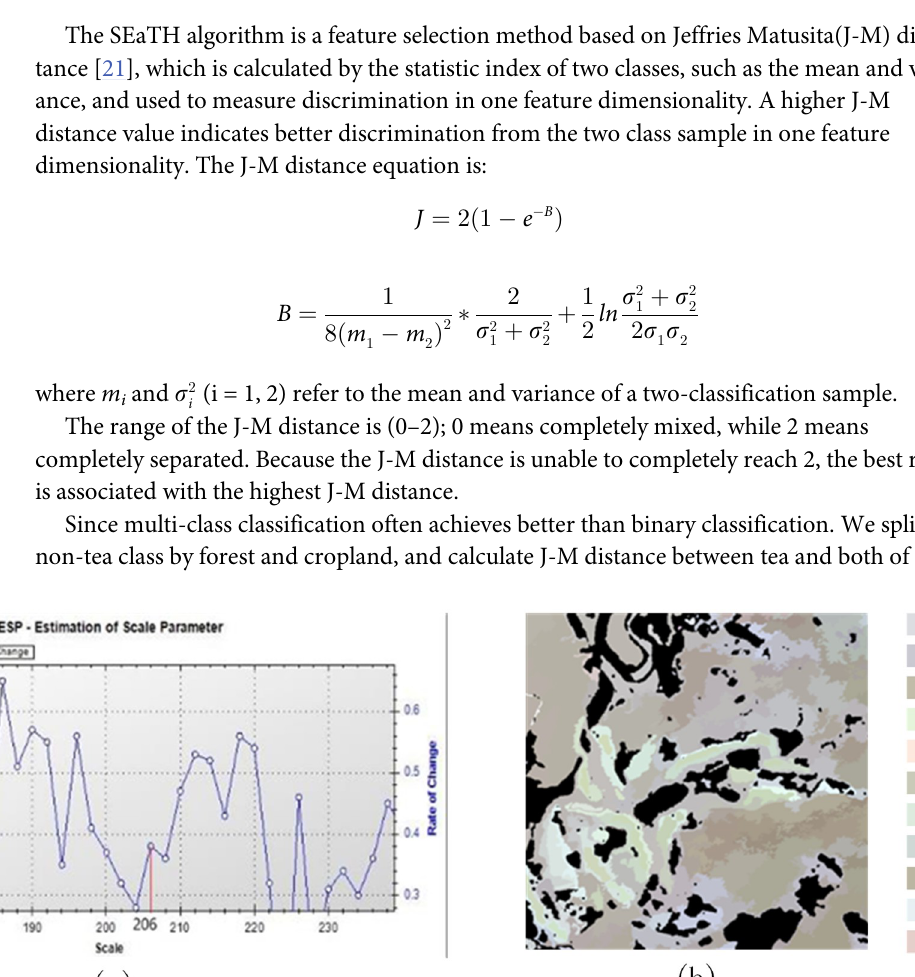
PLOS ONE | https://doi.org/10.1371/journal.pone.0263969 February 7,